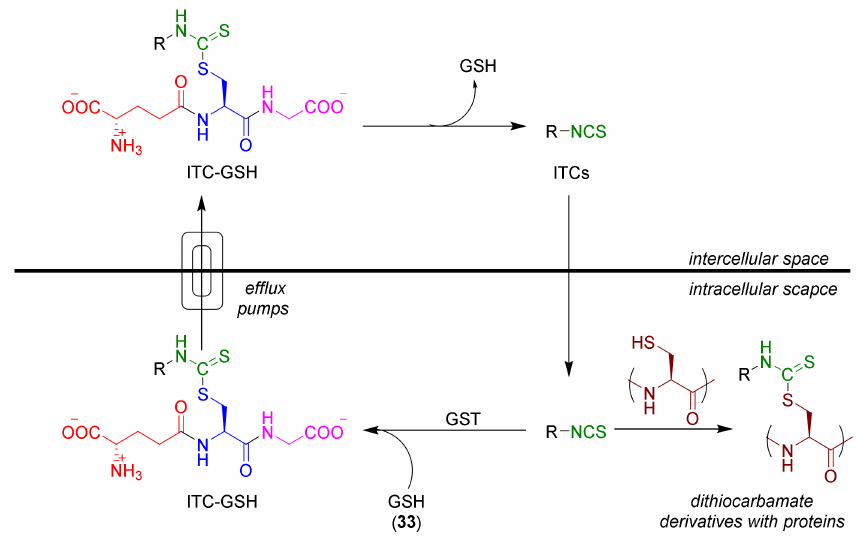
Figure 7. Accumulation of ITCs in the